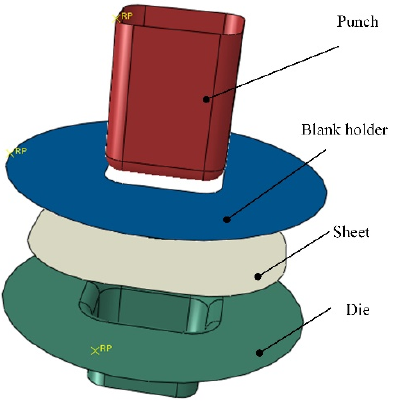
Figure 6. FE simulation model.